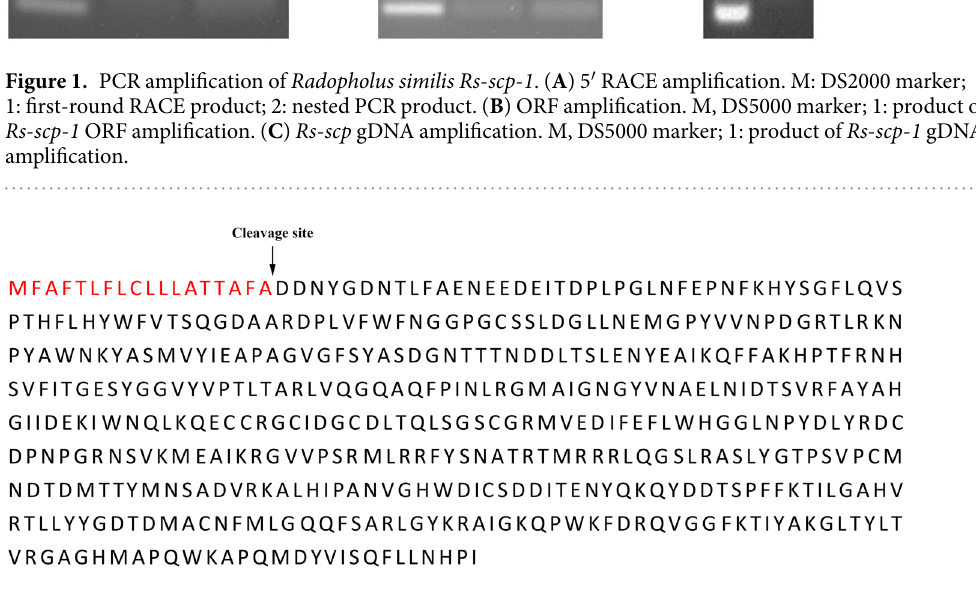
Figure 2. Sequence analysis of Radopholus similis Rs - scp - 1 (GenBank accession number: KJ617041.1). Signal peptide prediction of Rs - scp - 1 ; signal peptide sequence is in